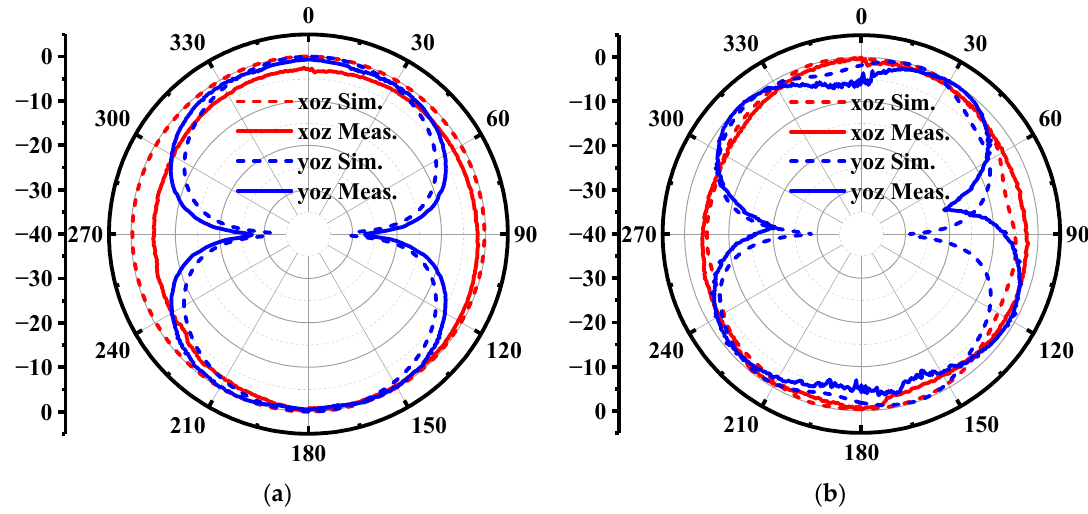
Figure 16. The simulated and measured radiation patterns of the wearable antenna in free space. ( a ) 0.4 GHz. ( b ) 1.2 GHz. Table 2. Comparison of the proposed antenna with other wideband wearable antennas. Ref.